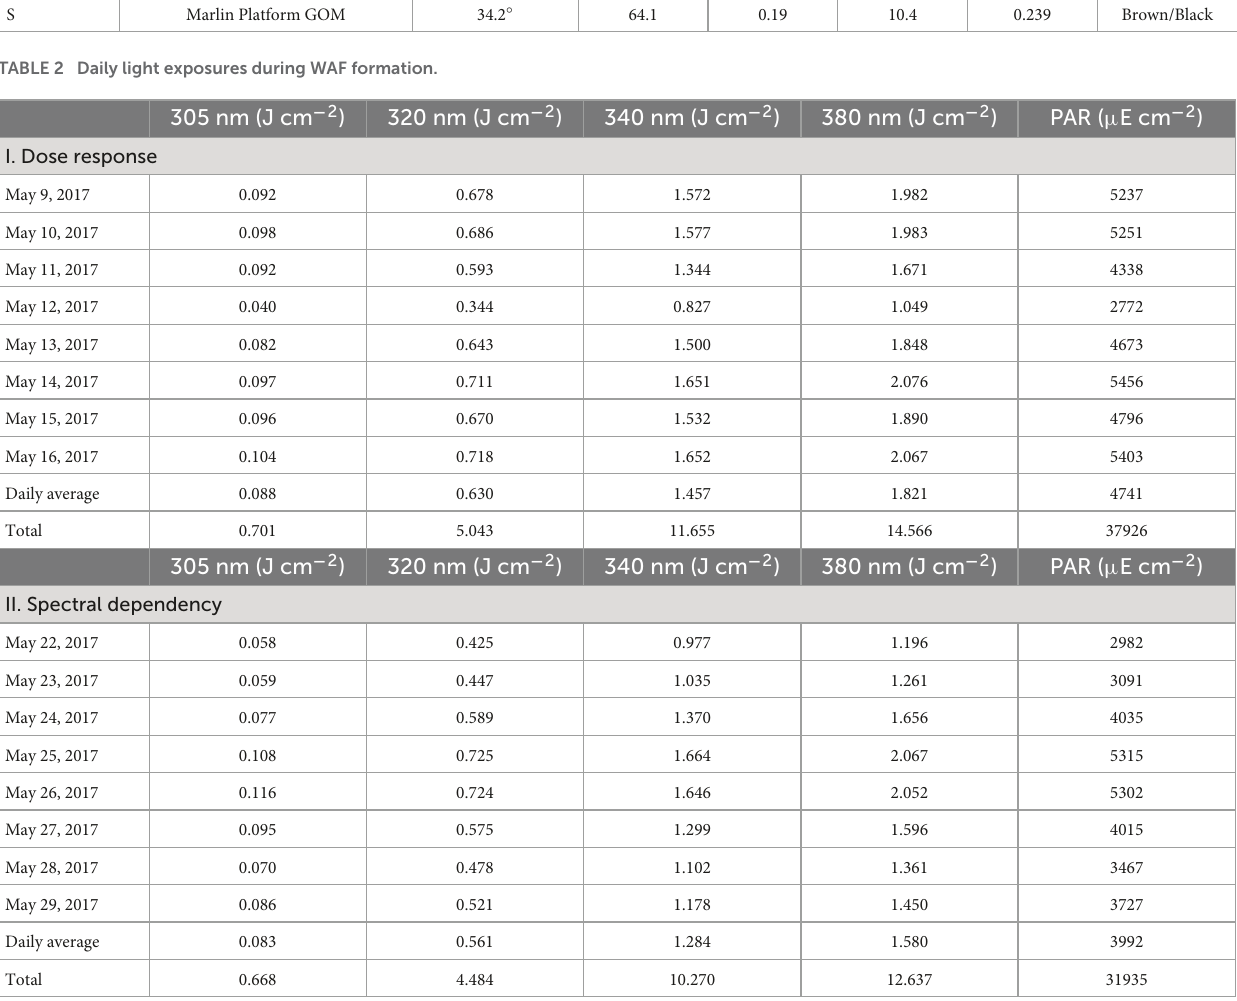
TABLE 2 Daily light exposures during WAF